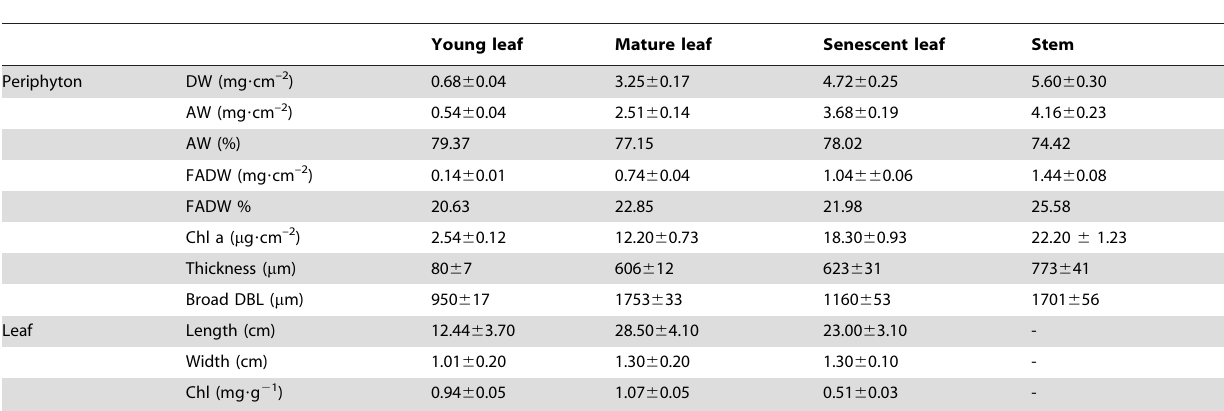
Table 1. The characteristics of periphyton on the leaves and stems of Potamogeton malaianus .